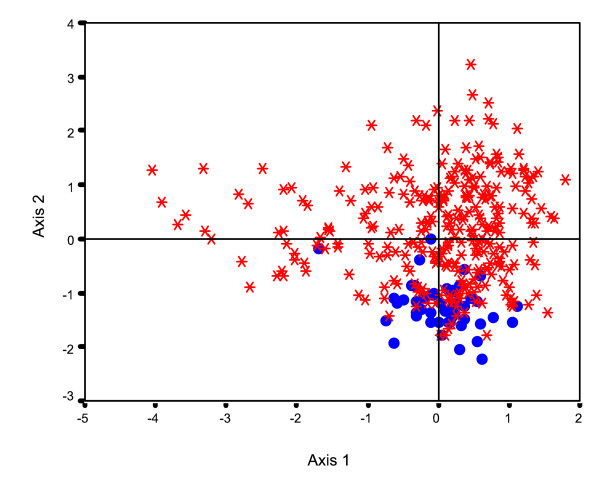
Plot of the two most dominant axes generated by PCA. Hot ORFs are represented by the red asterisks, while cold ORFs are represented by the filled blue circles.